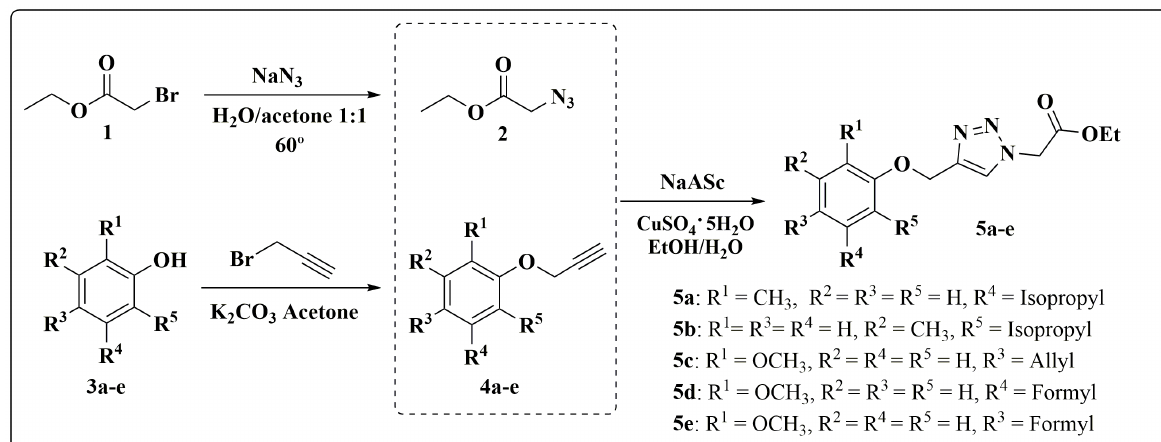
Figure 1. Reaction steps involved in the preparation of the new 1,4-disubstituted 1,2,3-triazoles